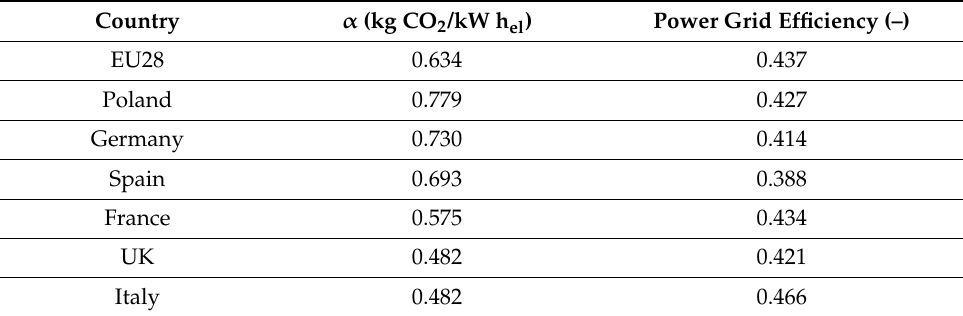
Table 1. Emission factors and power grid efficiency for some European countries [45].